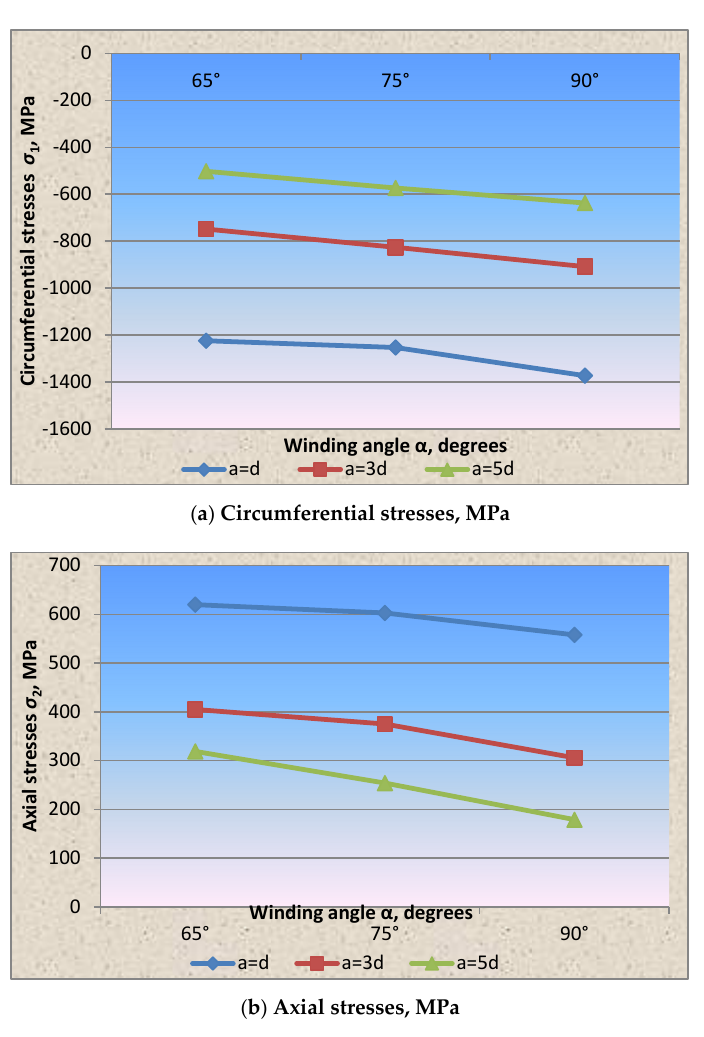
Figure 6. Dependence of the circumferential ( a ) and axial ( b ) stresses in the shell wall fragment on the winding angle with the winding wire diameter of 2.0 mm.